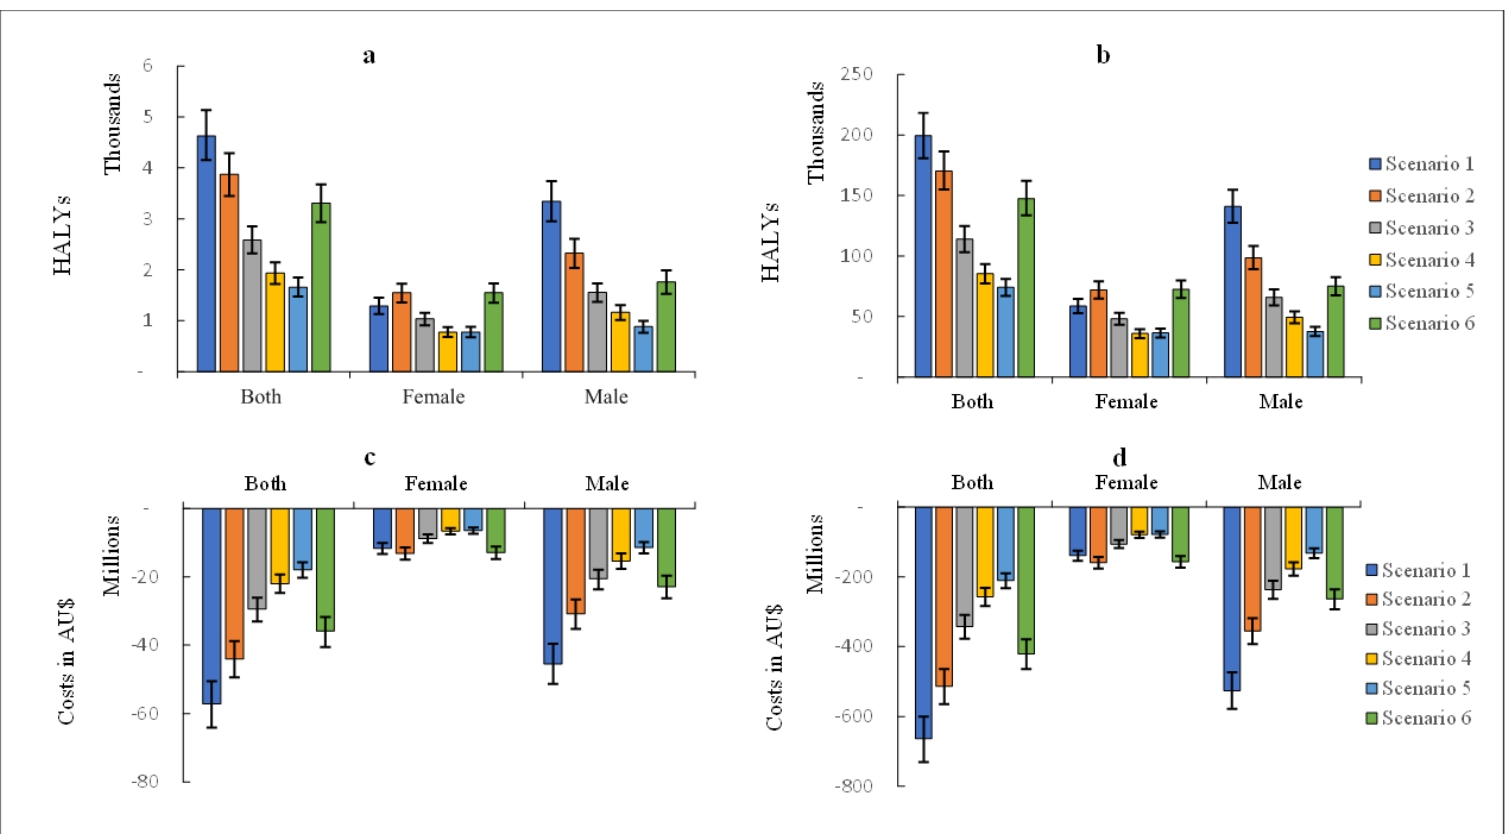
Figure 1. Health-adjusted life years (HALY) gained and CKD-related health expenditure savings. Panel ( a ) depicts the HALYs gained between 2019–2030 and panel ( b ) shows HALYs gained over the lifetime of Australians alive in 2019 by gender and for each of the six scenarios modelled; Panel ( c ) shows the CKD health expenditure savings between 2019–2030 while panel ( d ) shows the CKD health expenditure savings over the remaining lifetime of Australians alive in 2019. AUD, 2019 Australian dollars. Error bars reflect the 95% uncertainty intervals. Scenario 1: Reducing current salt intake to an average of 5 g/day (Australian Suggested Dietary Target); Scenario 2: a 30% relative reduction in current salt intake (National Preventive Health Strategy, 2021–2030 target); Scenario 3: 20% relative reduction in current salt intake; Scenario 4: 15% relative reduction in current salt intake; Scenario 5: reduction in current salt intake by 1 g; Scenario 6: reduction in current salt intake by 2 g. HALY, health-adjusted life